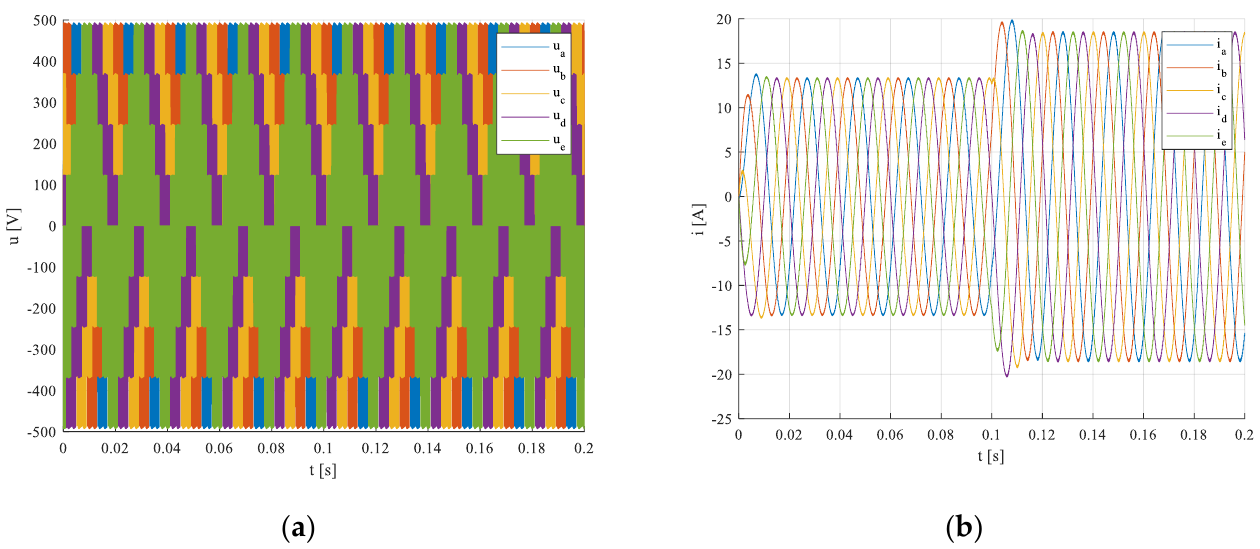
Figure 23. VSI inverter voltages ( a ) and currents ( b ) in 𝑎, 𝑏, 𝑐, 𝑑, 𝑒 - coordinate system during the transient.